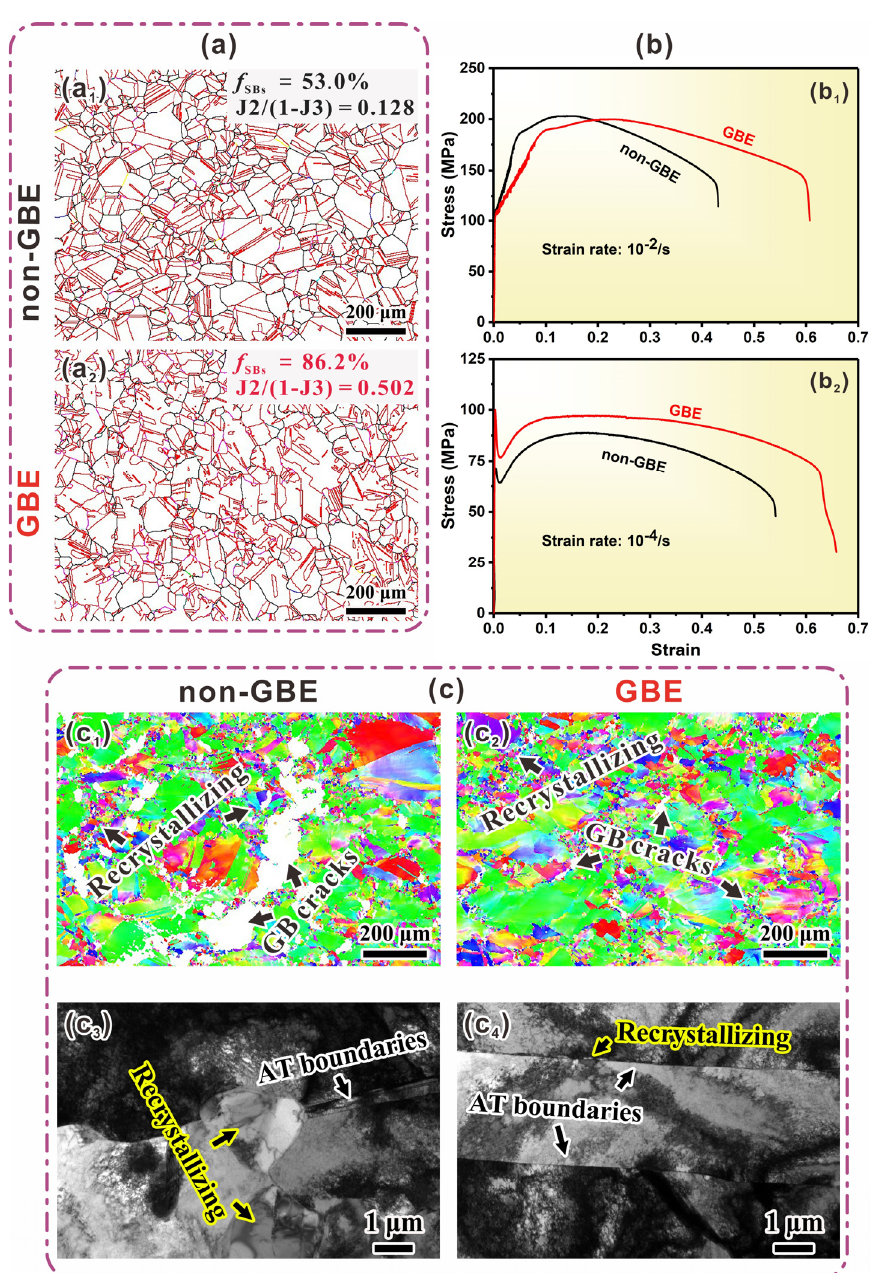
Figure 6. Influence of GBE on the tensile properties and deformation behavior of Cu-16at.% Al alloy at 723 K and at different strain rates. Comparisons of GBCD ( a ) and tensile property ( b ) between GBE and non-GBE samples, and the experimental evidence for the suppressive effects of GBE on the GB cracking (inverse pole figure maps c 1 ,c 2 ) and dynamic recrystallization (TEM images c 3 , c 4 ). adopted from Ref. [12]